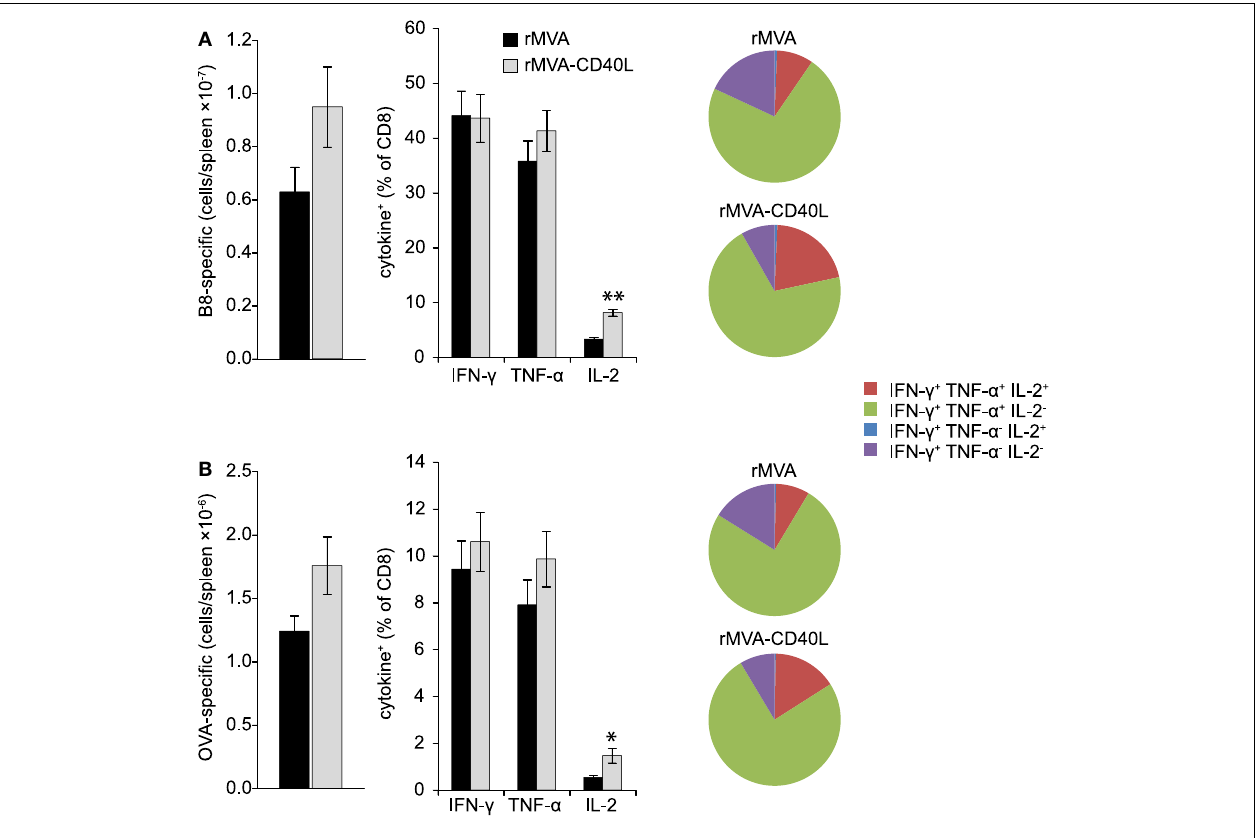
charts denote the fraction of IFN- γ + cells expressing IFN- γ alone (violet), IFN- γ andTNF- α (green), IFN- γ and IL-2 (blue), and IFN- γ ,TNF- α , and IL-2 (red). Note the increased percentage of IFN- γ /TNF- α /IL-2 triple producer cells in rMVA-CD40L immunized mice (red area).Thus, in comparison to rMVA rMVA-CD40L immunization leads to functionally improved memory CD8T cells. Data are representative of five mice per group and two independent